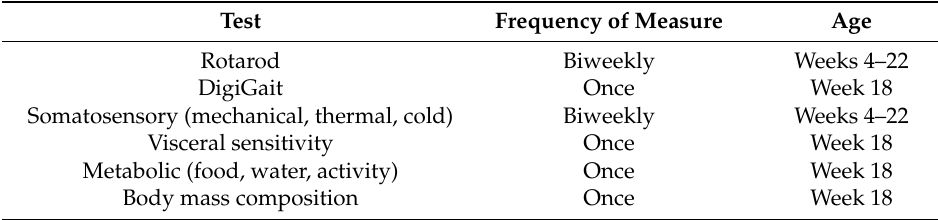
Table 4. Behavioral testing